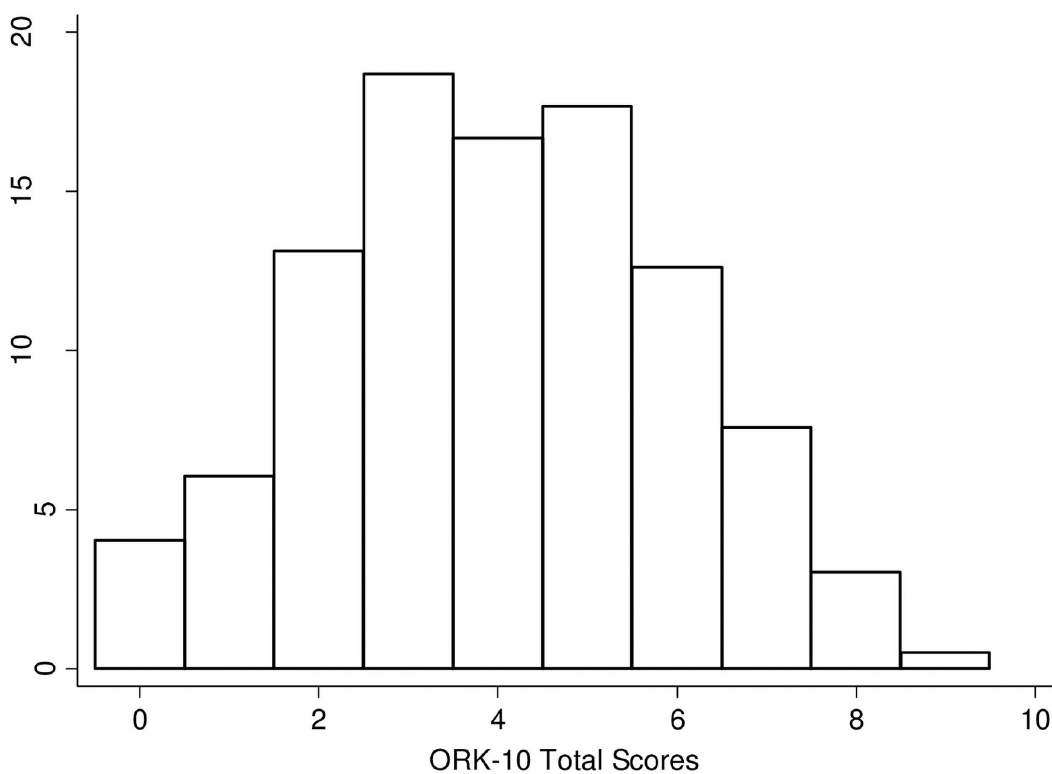
Fig 2. Display of 198 parent scores on the ORK-10 scale that examines knowledge of obesity knowledge related to health risks. The histogram displays the percent of parents meeting each total